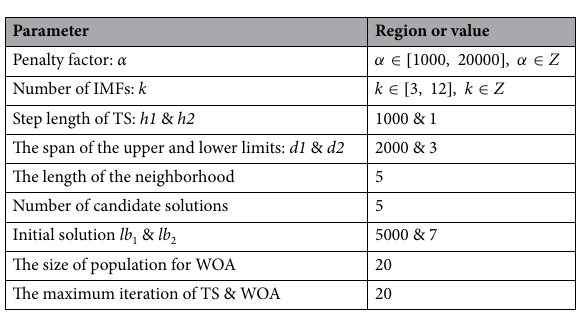
Table 1. The initial parameters of the optimization algorithm.